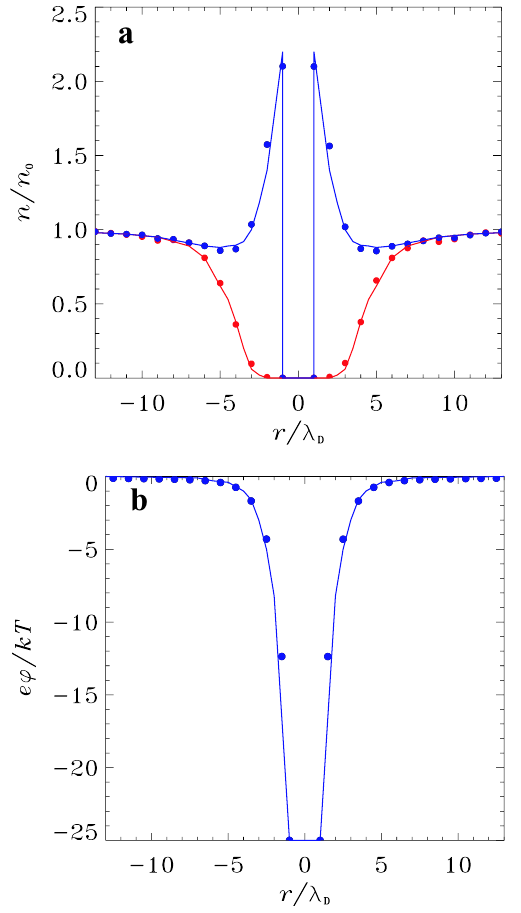
Fig. 6. (a) Density distribution around the spherical probe for at- tracted (blue) and repelled (red) particles; (b) potential profile in the sheath in the case of a non-flowing plasma with λ D = r s = 2cm, probe potential ϕ =− 25 kT/e . Results of Laframboise are shown by solid lines and the model solution by dots. Charge densities are normalised by their values in the undisturbed plasma, distances by the Debye length, potentials by plasma temperature.